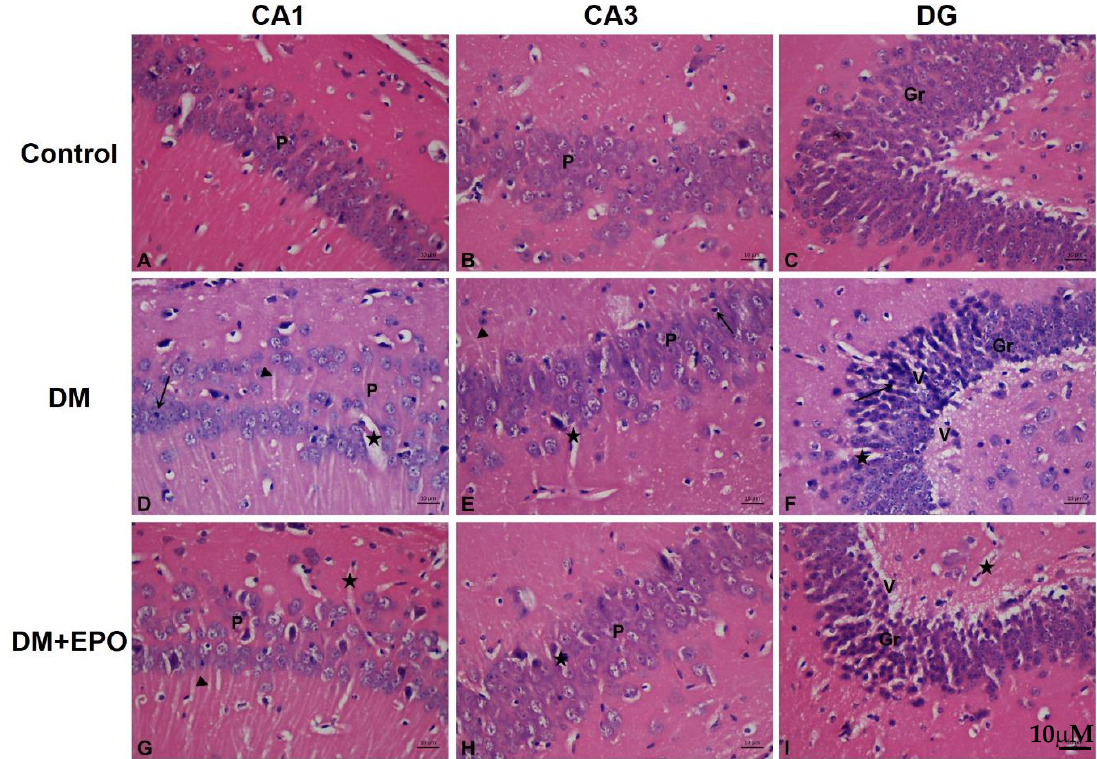
Figure 2. Hemeotoxylin and Eosin staining of the CA1, CA3 and dentate gyrus (DG) regions of the hippocampus from control, diabetic (DM) and erythropoietin-treated diabetic (DM+EPO) mice (images A–I ). Magnification × 400. In the CA1 region of DM mice, there were areas of cellular loss and cells with dark small nuclei (arrow), note the wide blood capillaries (star) and clumping of cellular processes (arrow heads). In the CA3 region of DM mice there were numerous dilated blood capillaries (star), and dark cells with dark small nuclei (arrow), there was clumping of cellular processes (arrow head). In the DG of DM mice there was: marked cellular degeneration with many dark cells having small dark nuclei (arrow). There was wide blood capillaries (star) within the granular layer. There were areas of marked vacuolization in most areas (V). In the CA1 region of DM+EPO